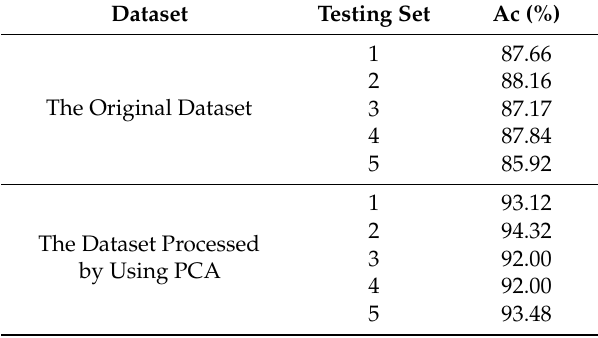
Table 7. Five-fold cross validation results shown using our proposed method on yeast